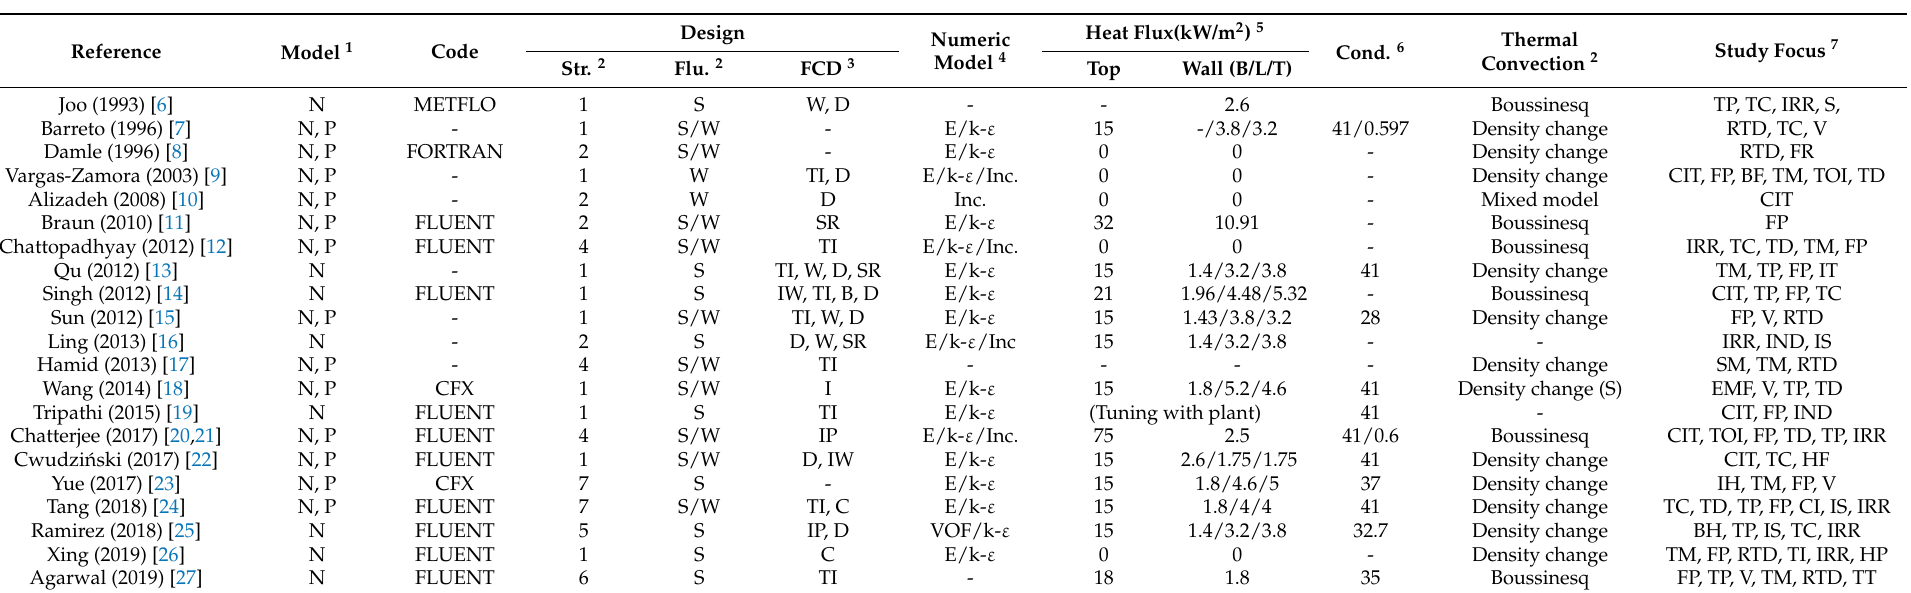
Table 1. Summary of mathematical modelling investigations in a tundish under non-isothermal conditions.